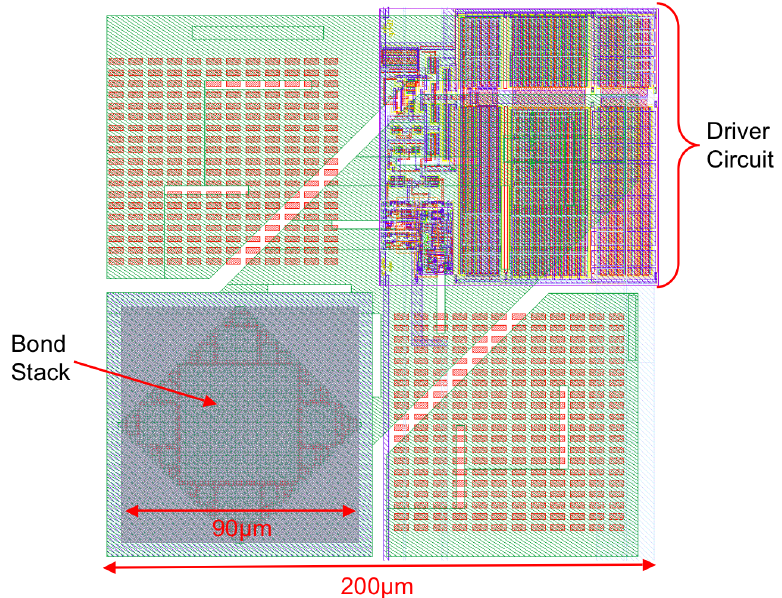
Figure 4. Layout of a single micro-LED driver